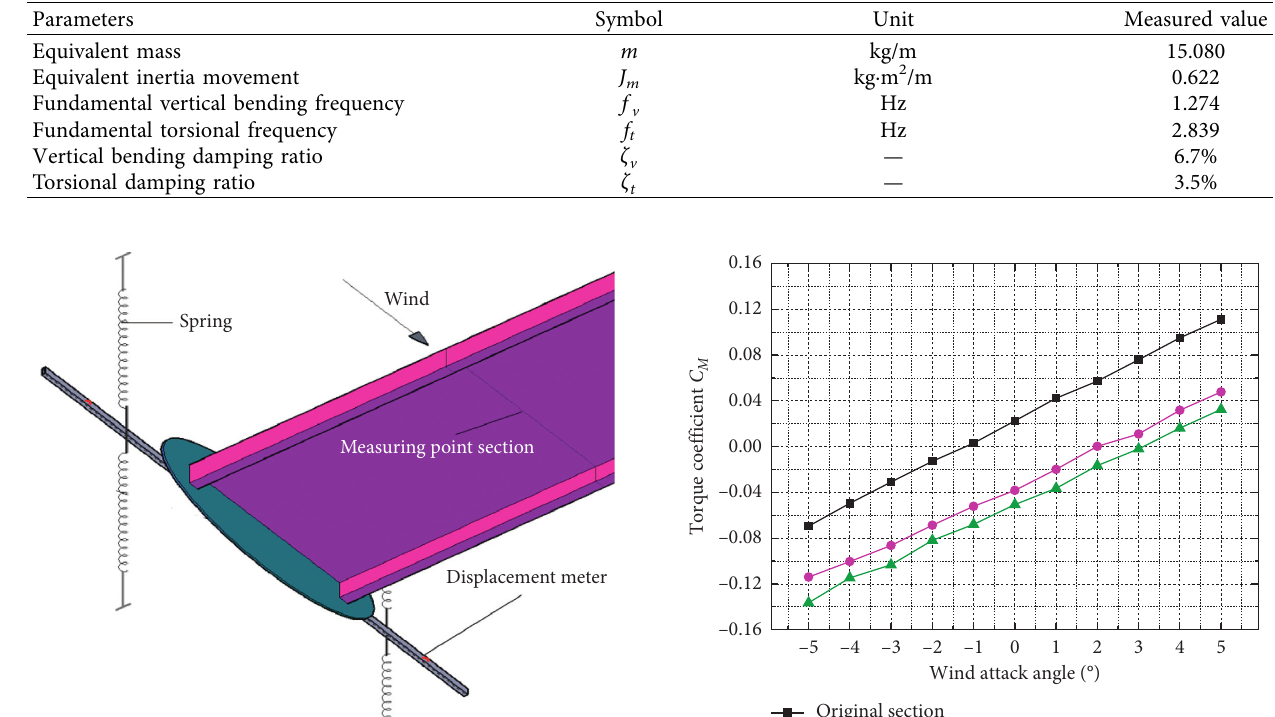
Figure 4: Schematic diagram of the synchronous measurement system.